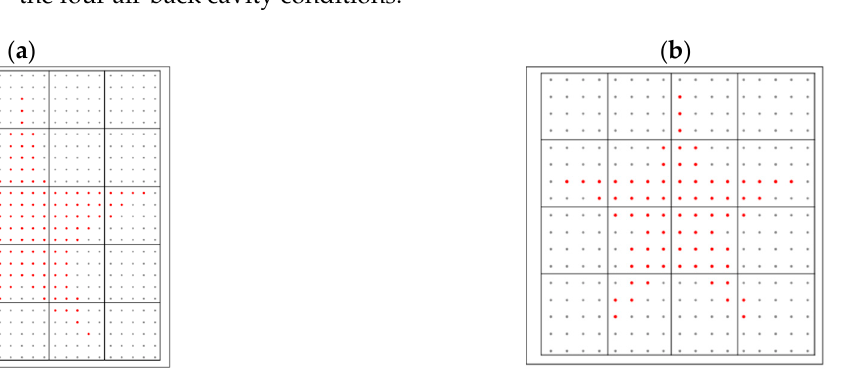
Figure 11. Schematic diagram of the division into parts to calculate the standard deviation of the num- ber of the larger holes: ( a ) 25 horizontal and 25 vertical rows; ( b ) 17 horizontal and 17 vertical rows. Table 7. Comparison of the standard deviation (SD) and error indices (Equations (4)–(6)) of specimens